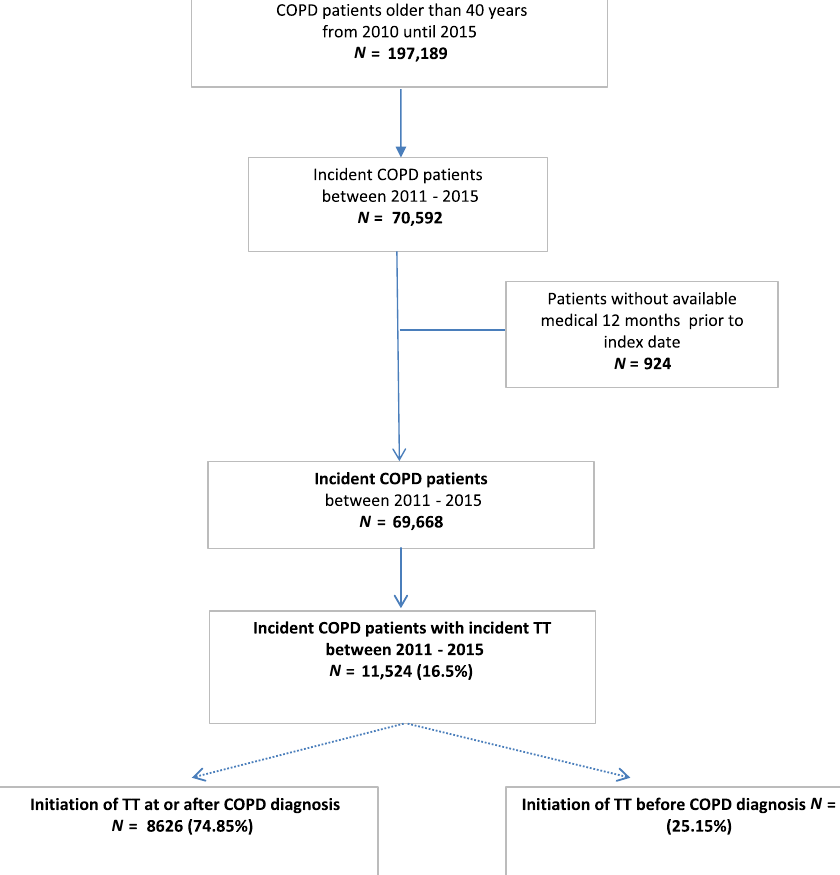
Fig. 1 Flowchart of the study. COPD : chronic obstructive pulmonary disease; TT : triple